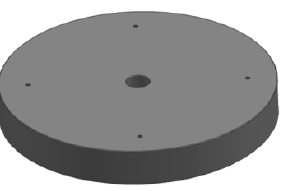
Figure 18. Three-dimensional model of standard parts.